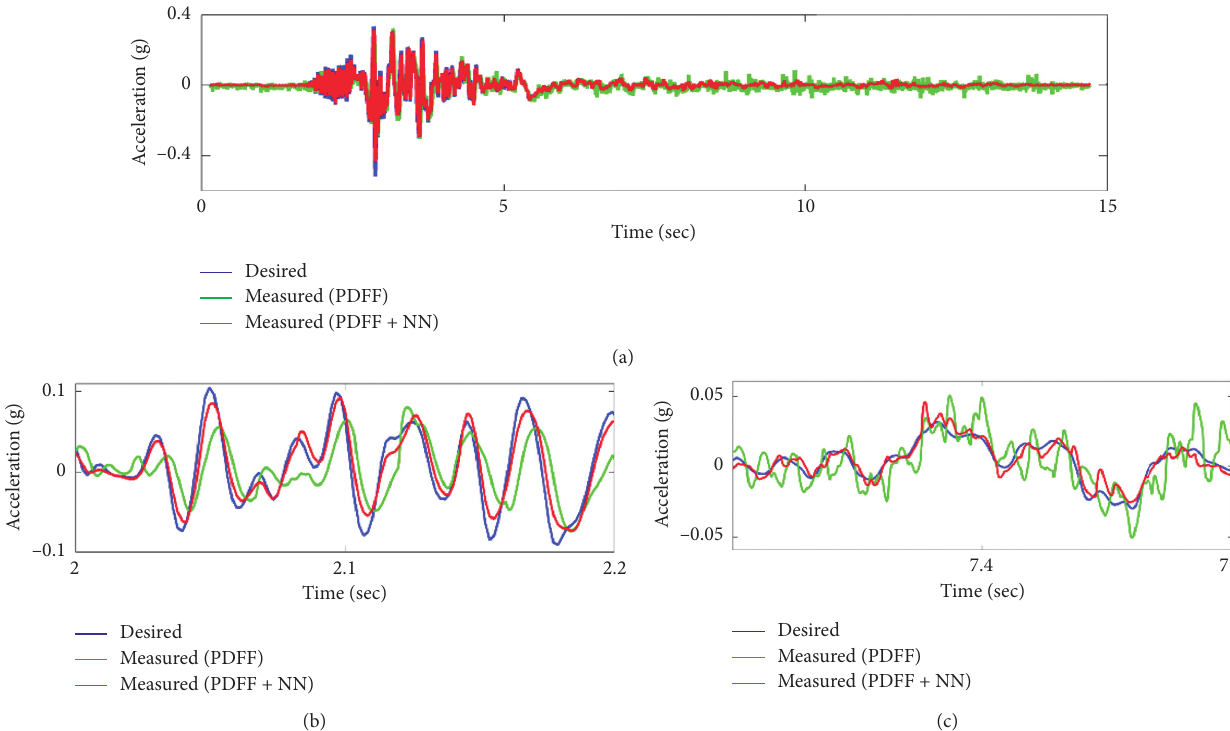
Figure 10: Time history comparison between the measured and the desired acceleration for the El Centro earthquake record (unloaded